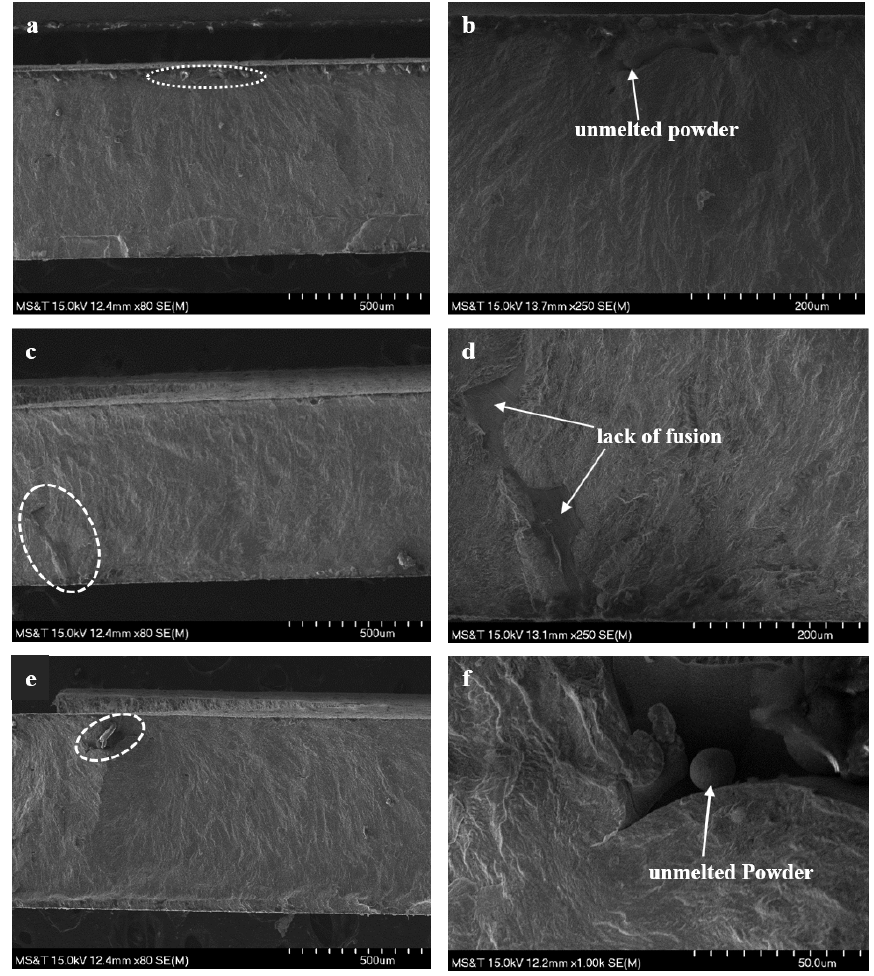
Figure 11. Scanning electron microscope (SEM) images of the fracture surfaces with possible crack initiation sites (marked by white dashed circles) of the specimens fabricated by the nominal parameters; ( a ): horizontal orientation; ( b ): A magnified view of crack initiation site in (a); ( c ): vertical orientation; ( d ): A magnified view of crack initiation site in (c); ( e ): inclined orientation; and ( f ): A magnified view of crack initiation site in